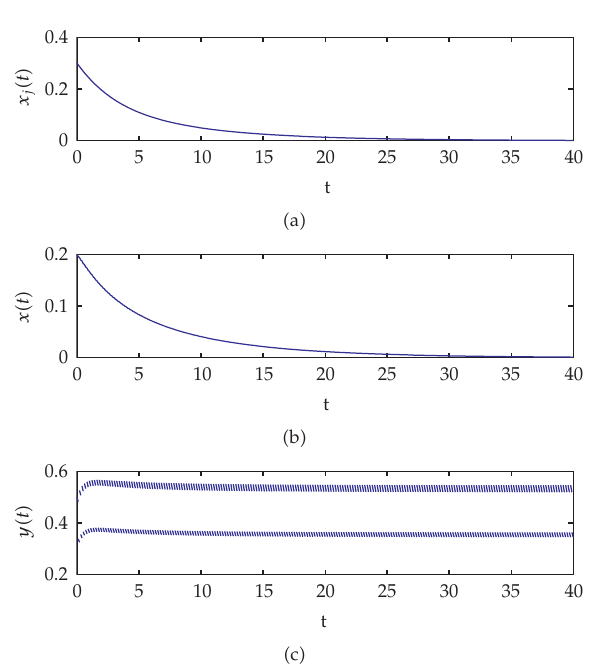
Figure 3: Time series of system (cid:3) 2.4 (cid:4) with parameters d (cid:8) 0 . 6; d 1 (cid:8) 0 . 4; α (cid:8) 0 . 8; τ (cid:8) 2; d 2 (cid:8) 0 . 5; β (cid:8) 0 . 8; λ (cid:8) 0 . 9; p (cid:8) 0 . 3; μ (cid:8) 0 . 2; T (cid:8) 0 . 2.